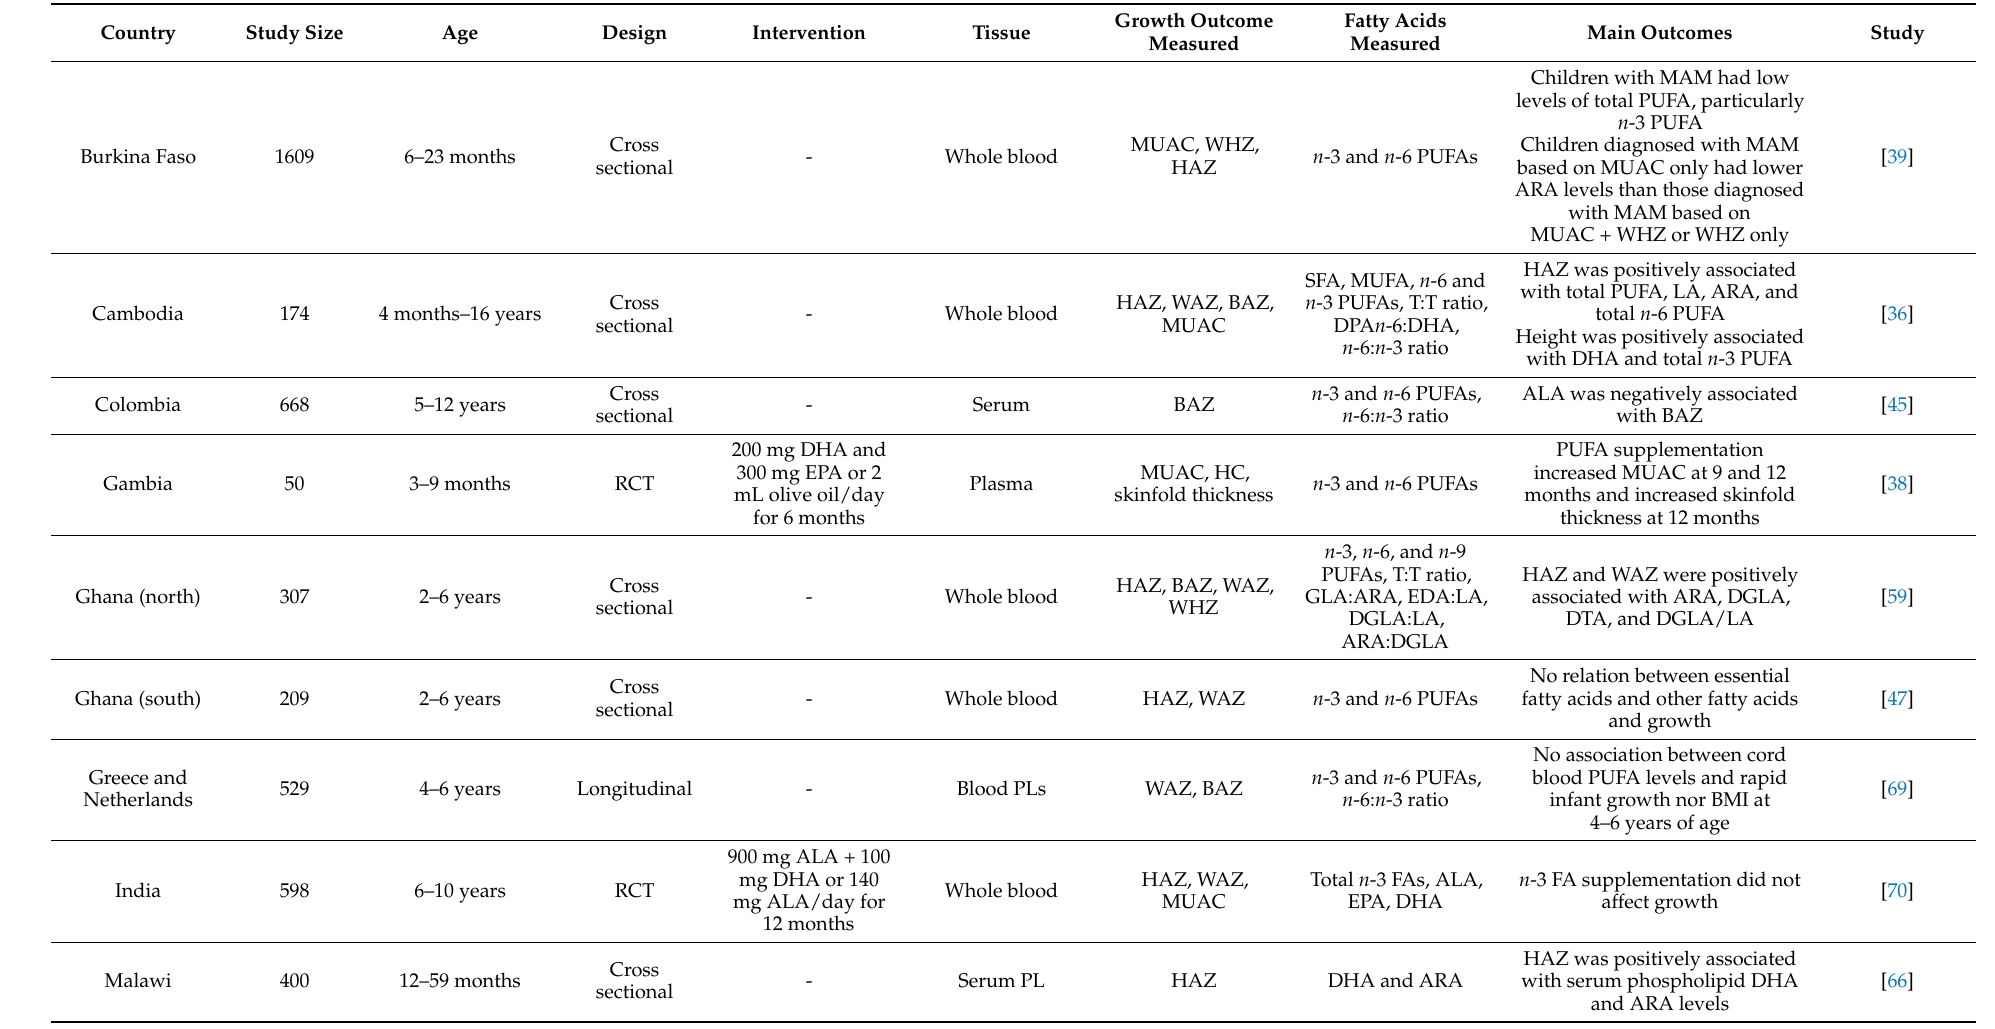
Table 2. Associations between blood fatty acid levels and growth outcomes among child populations in different countries and